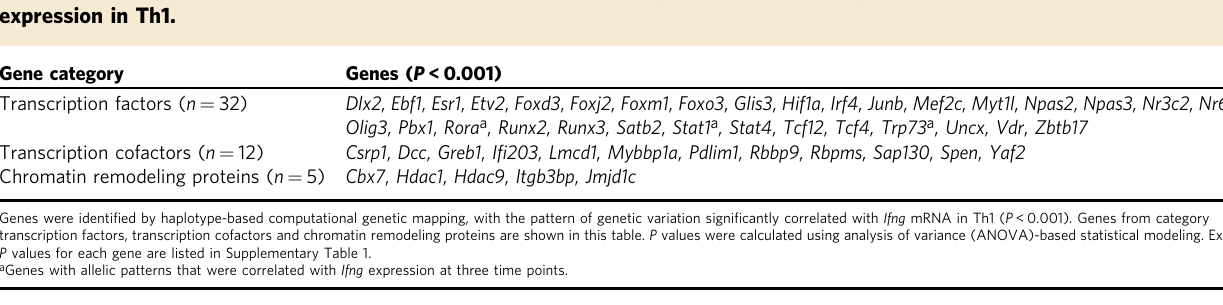
Table 1 Transcription factors, cofactors, and chromatin remodeling proteins with allelic patterns that are correlated with Ifng expression in